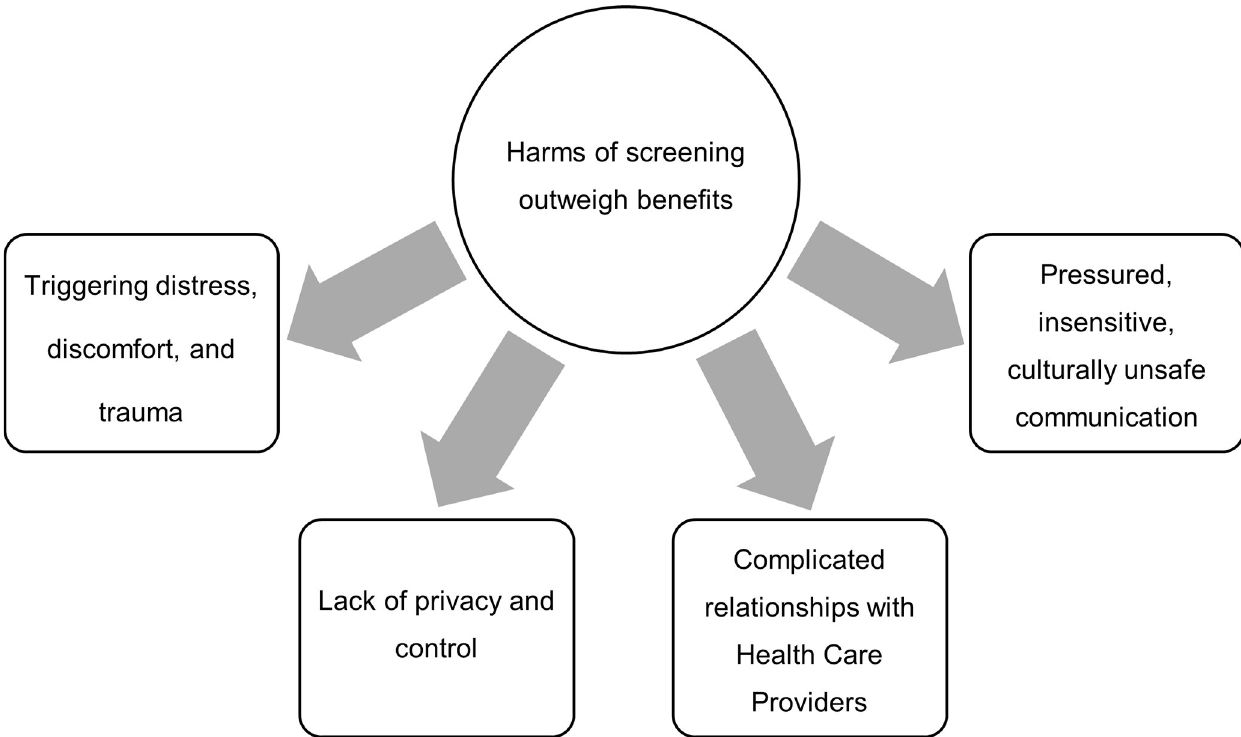
Fig 1. Key themes underlying under-screened women’s views of cervical screening.